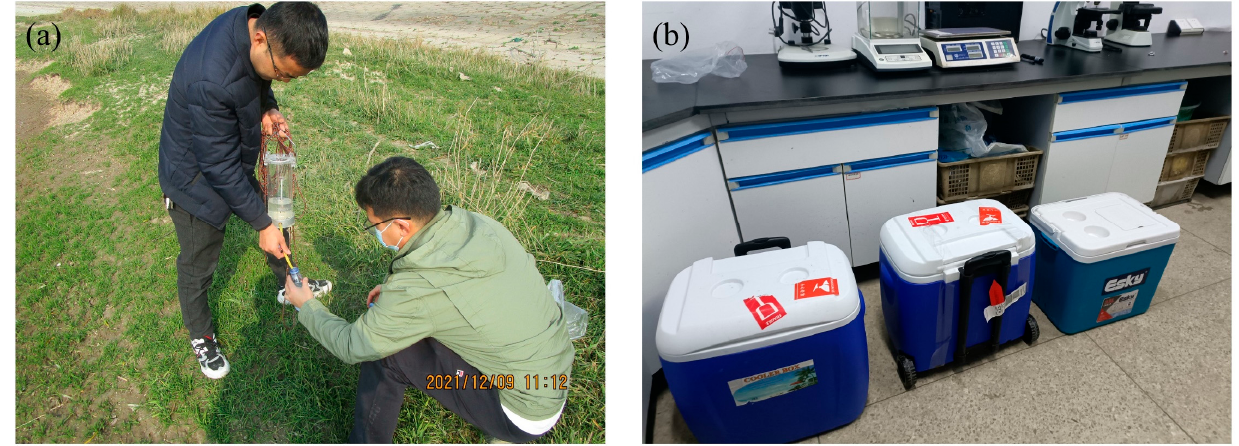
Figure 3. Photographs of field water sample collection and storage: ( a ) collection of a water sample from the Zhanghe River and ( b ) water sample storage.